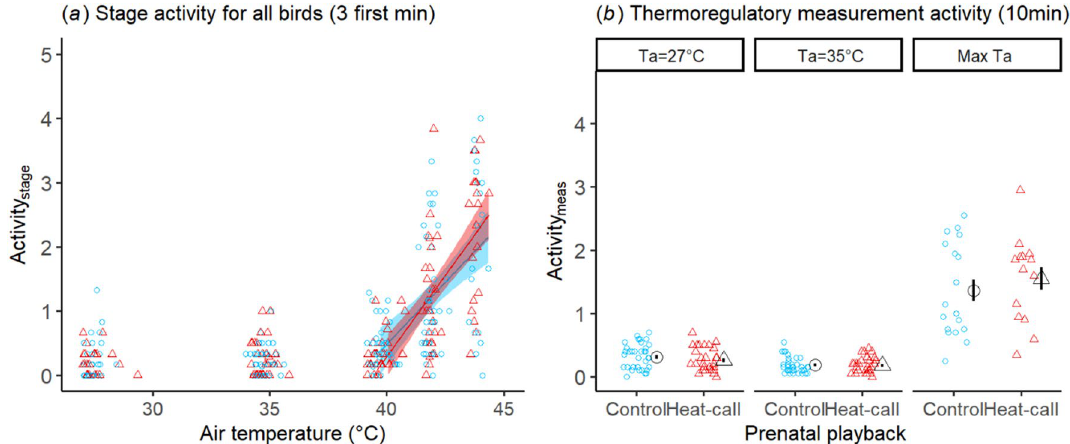
Figure 2. ( a ) Activity over a stepped profile of increasing T a (n = 242 observations), using activity recorded in the first 3 min of stable T a per stage (activity stage ), for all birds tested (unless trial terminated within < 3 min of T a stage start n = 12). Regression lines display significant relationship from LMM above the inflection point (T a = 39.6 ± 0.5 °C), split by prenatal playback: birds had been prenatally exposed to either heat-calls (red triangles) or control calls (blue dots). ( b ) Activity in the 10 min prior and during measurement (activity meas ), for calm birds from which we obtained thermoregulatory values, at T a = 27, 35 °C (n = 67) and at the max T a reached (n = 32). Markers and error bars show mean ± SE.